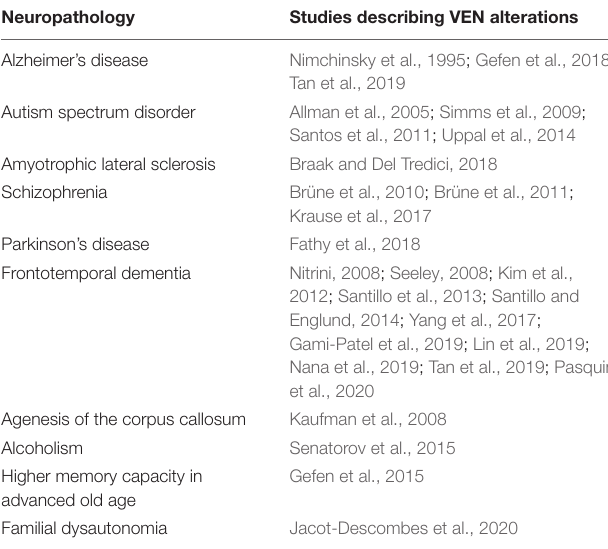
TABLE 2 | Alterations of VENs in various neuropathological or neurodivergent